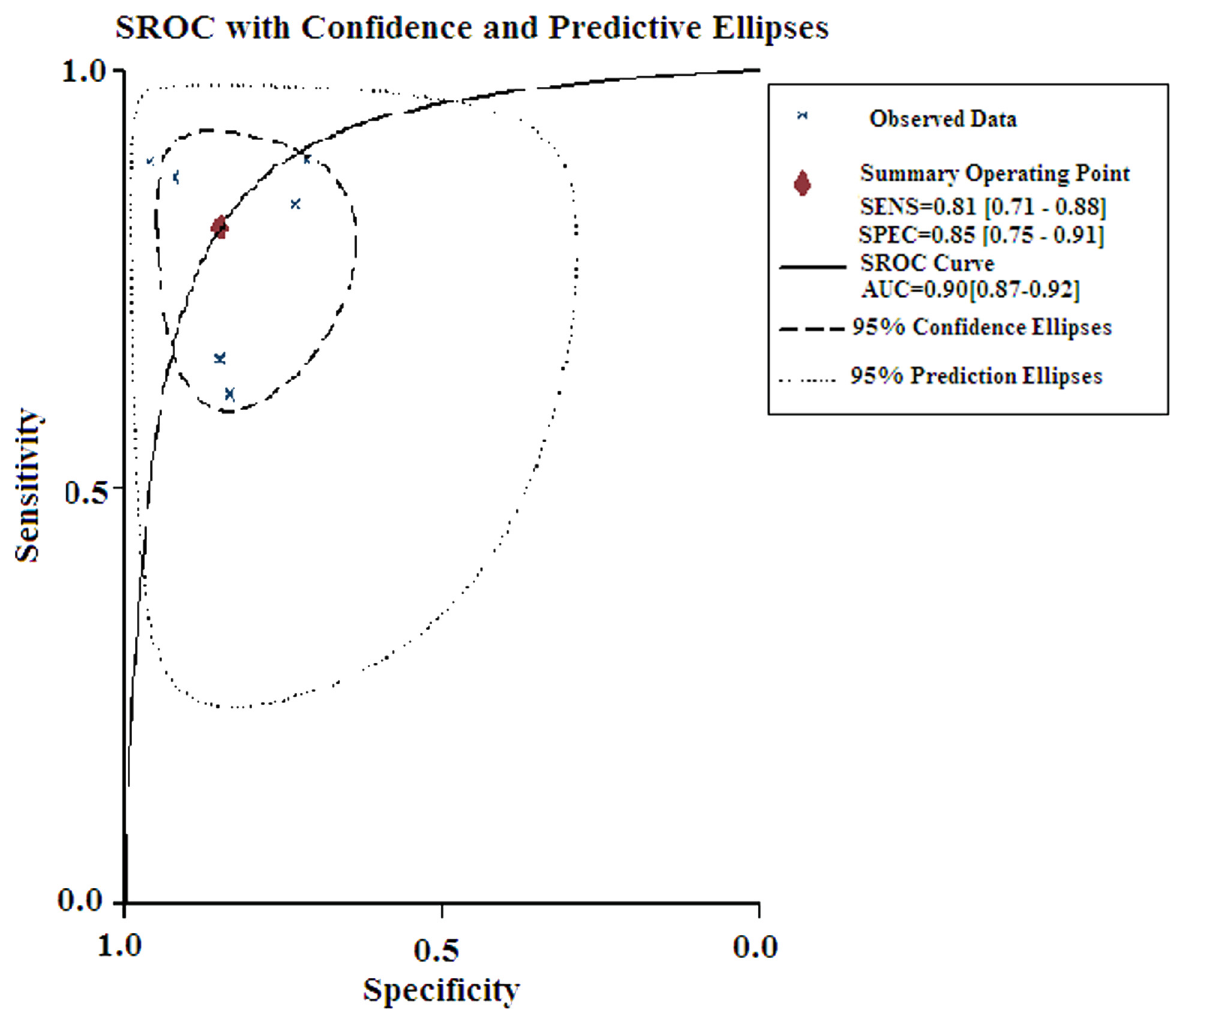
Fig 3. Summary receiver operating characteristic curves for miR-21 in the diagnosis of